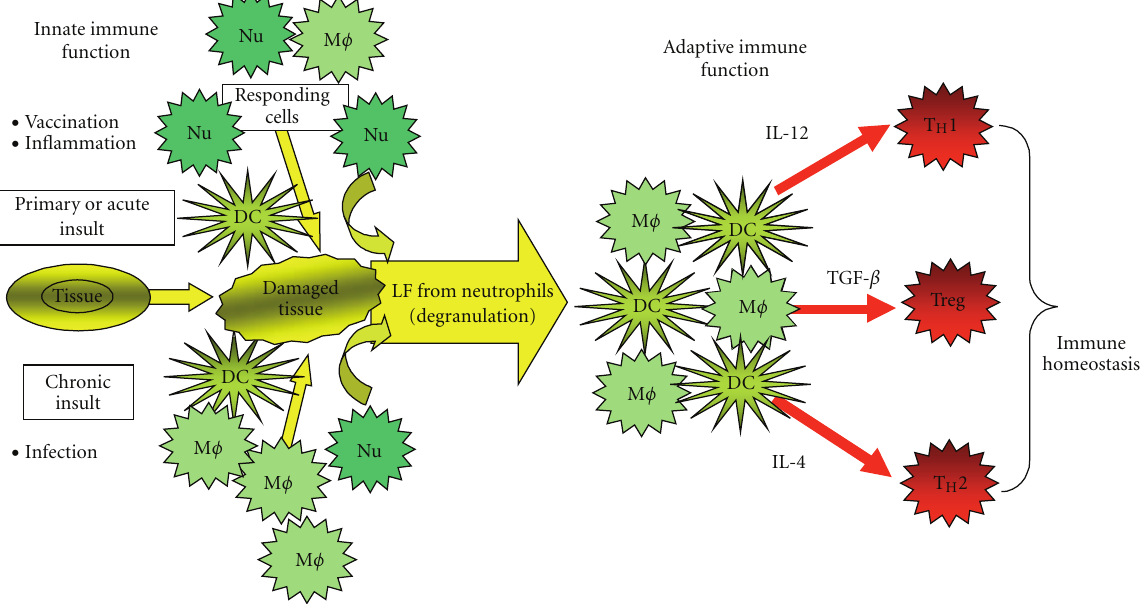
Figure 1: Lactoferrin as a bridge between innate and adaptive immune function. Insult, defined as infection or inflammatory stimulation, leads to activation of the monocyte/macrophage system (MØ), including neutrophils (Nu). In the case of primary vaccination, dendritic cells (DCs) are also directly mediated. Activated neutrophils (Nu) degranulate at the site of inflammation and release lactoferrin. Depending on the magnitude and/or duration of the insult, DCs mature to express di ff erential amounts of specific cytokines that a ff ect local environments to subsequently promote T-cell polarization into T H 1, T reg , or T H 2 phenotypic populations (diagram adapted from